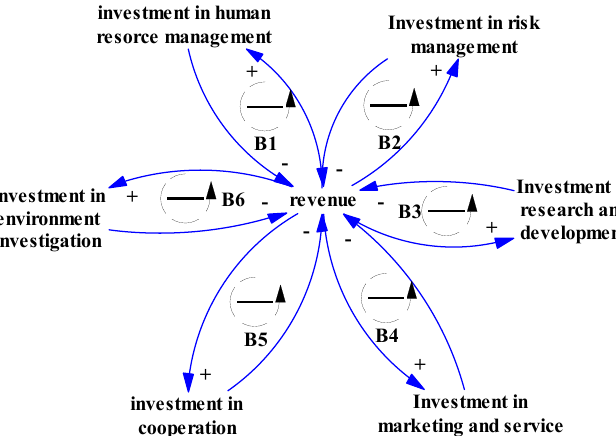
Figure 3. A Causal Loop Diagram of entrepreneurs’ view of entrepreneurship (Part II balancing loops).